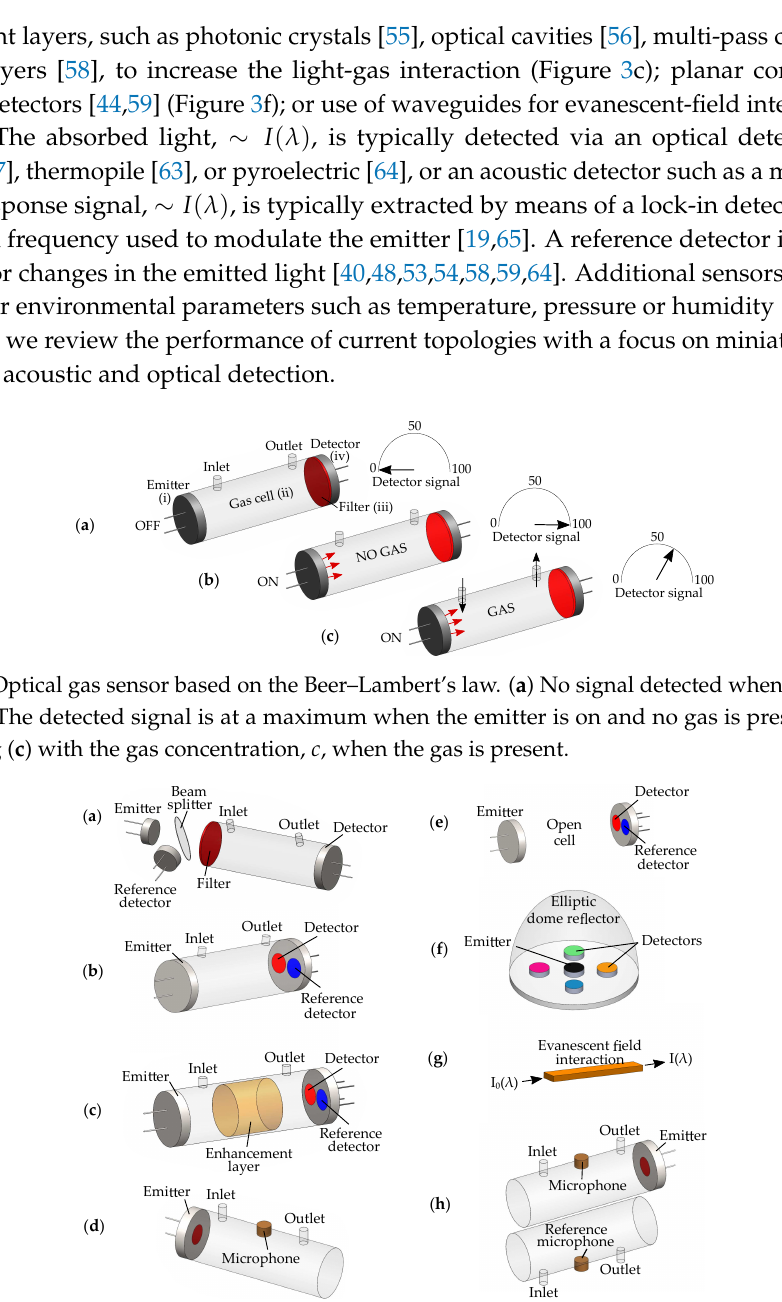
Figure 3. Optical gas sensors topologies. Most commonly used sensors rely on gas cells formed between face-to-face configured emitters and detectors. ( a ) Light can be filtered prior interaction with the gas. An external reference detector can be used to compensate for changes in the emitted light [53]. ( b ) Dual detector configuration, with [48,58] or without [54] filters. ( c ) The gas cell can be reduced by increasing the light-gas interaction, e.g., by using photonic crystals [55], optical cavities [56], multi-pass cells [57], or gas enrichment layers [58]. ( d ) Photoacoustic cell. Acoustic waves created by light-gas interaction are detected by a microphone. It can be resonant [67] or non-resonant [68]. ( e ) Open cell configuration, using either dual optical detection [64] or microphones sealed with target gases [69]. ( f ) Cell with emitter and detector in planar configuration. Multiple optical detectors with filters in the range of interest can be used [59], or microphones sealed with target gases [44]. ( g ) Waveguide sensors based on evanescent field interaction [60–62] require optical coupling with both emitters and detectors. ( h ) Dual photoacoustic cell with reference microphone